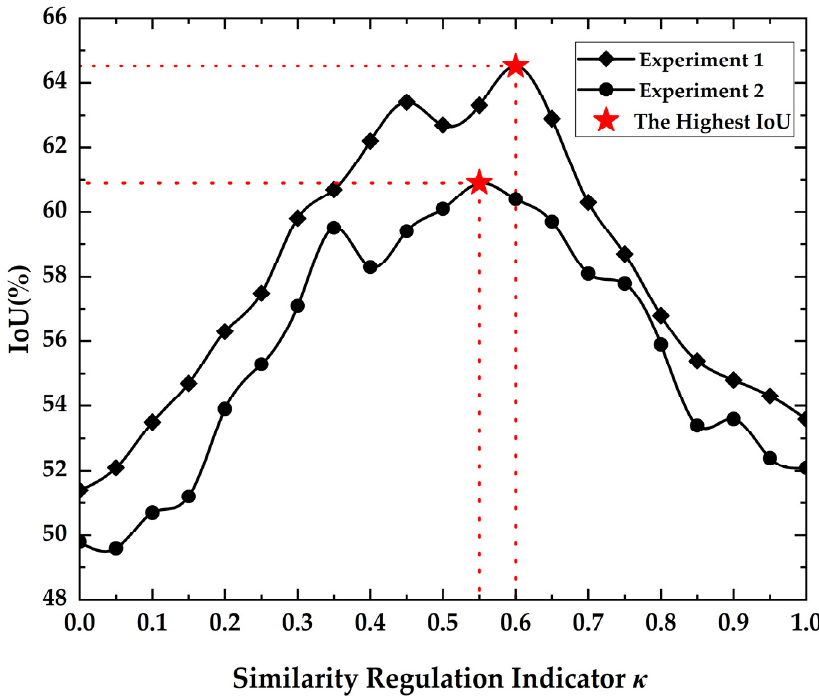
κ and IoU. Figure 11. The relationship between similarity regulation indicator κ and IoU.